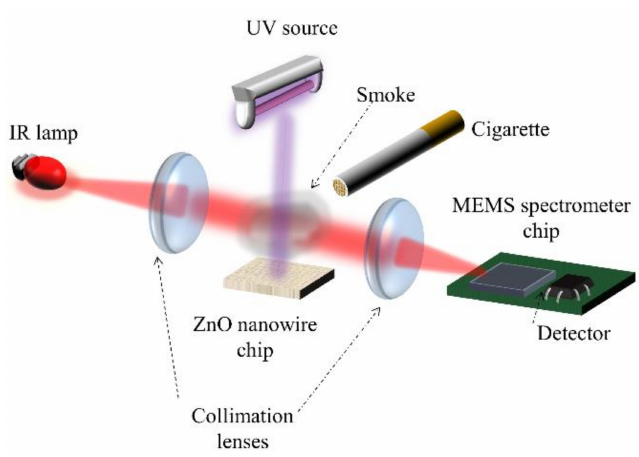
Figure 1. Photocatalysis setup with timely monitoring of air purification.